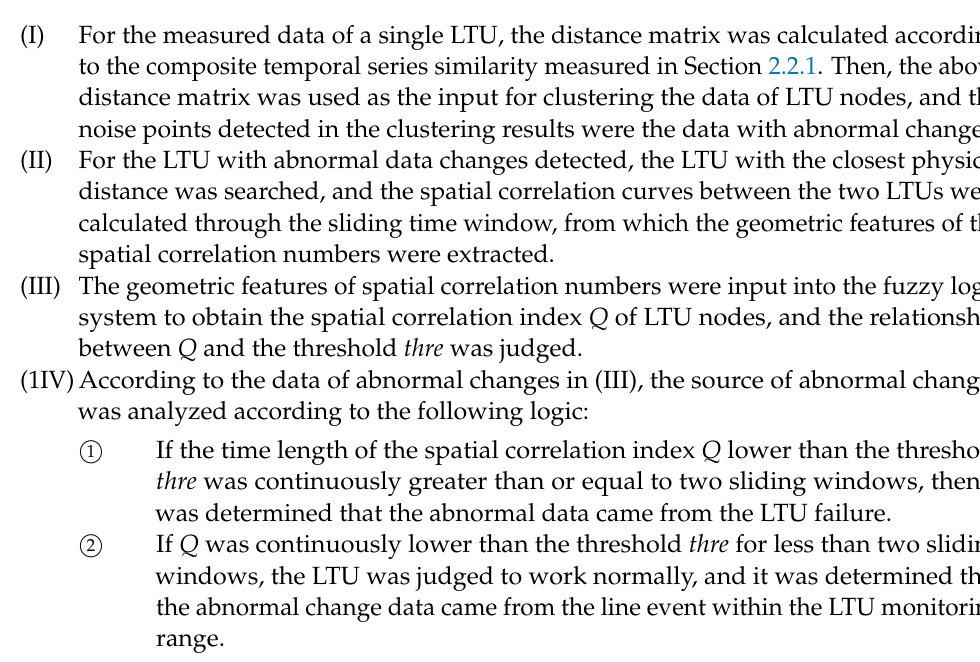
Figure 7. The overall structure of the